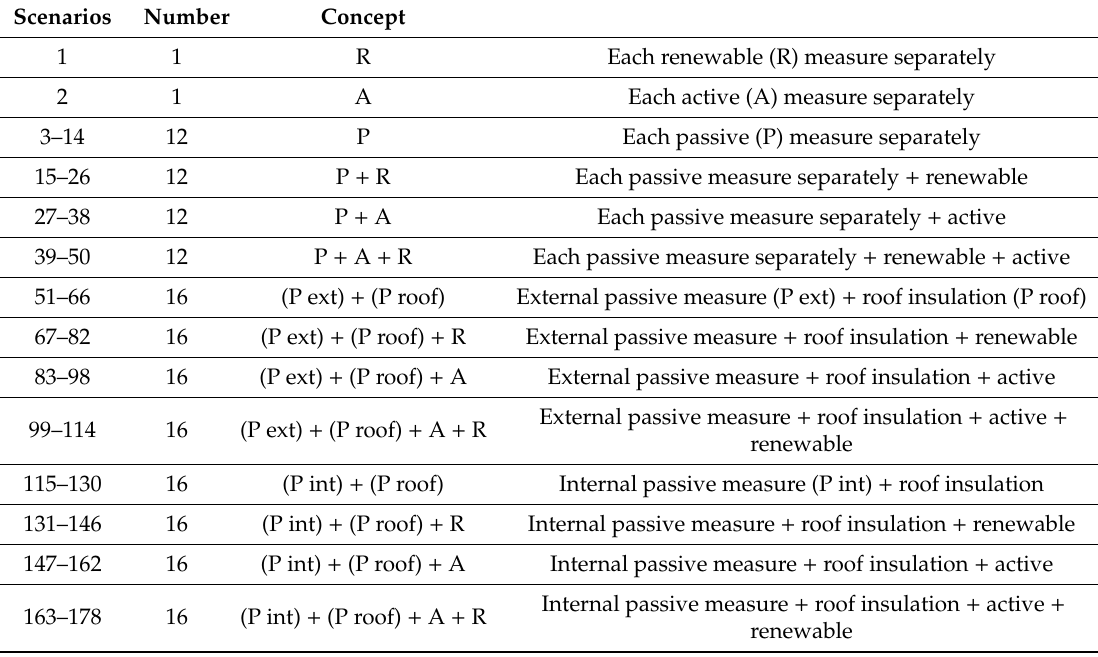
Table 8. List of scenarios generated for the